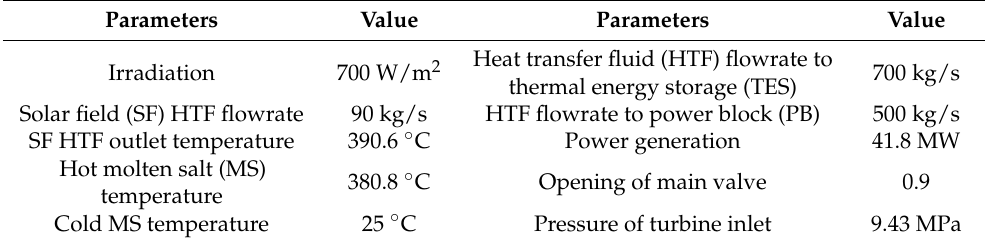
Table 1. Operating parameters under steady-state operation condition.